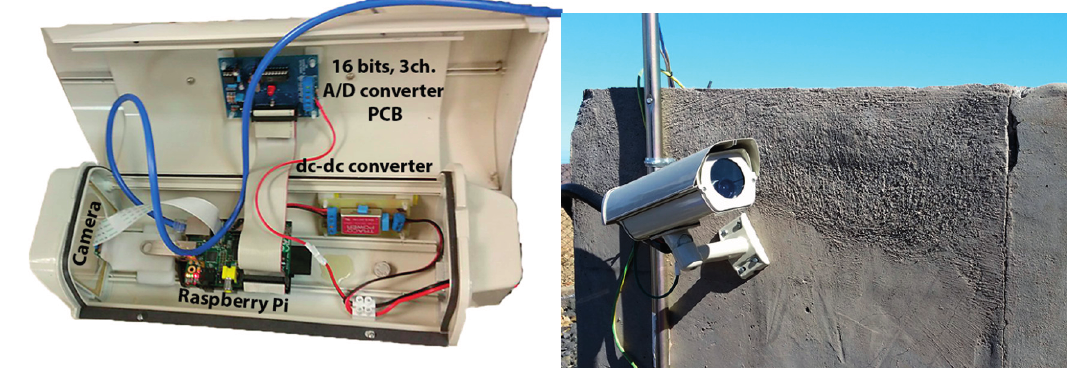
Figure 16. Imaging monitoring